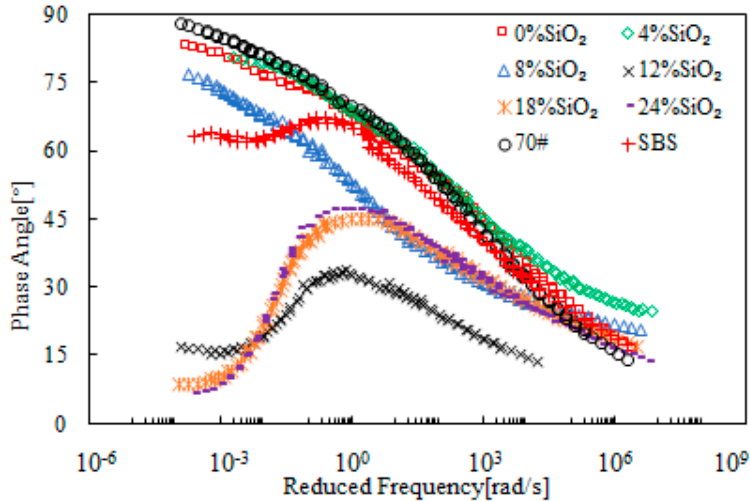
Figure 12. Master curves of the phase angle of SiO 2 -modified bitumen emulsion.